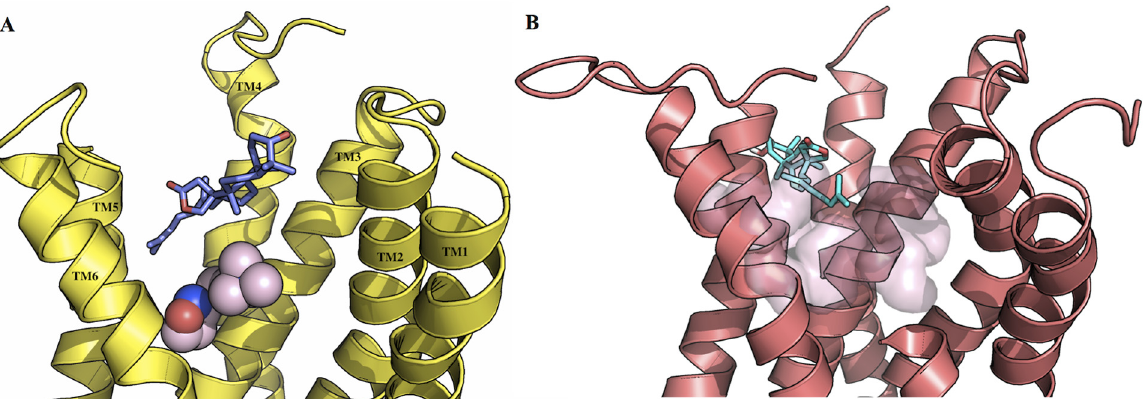
Fig 4. Docking of the ebelin lactone to (A) the M 1 mAChR and (B) the 5-HT 2A models. Iperoxo (sphere) from the crystal structure of M 2 mAChR (PDB code: 4MQS) was used to show the orthosteric site in the M 1 mAChR, and the transparent surface represents the orthosteric site of the 5-HT 2A receptor. Ebelin lactone bound to a cavity directly above the orthosteric site suggesting it could be an allosteric modulator. For the purpose of clarity, some of the loops and transmembrane helix are not